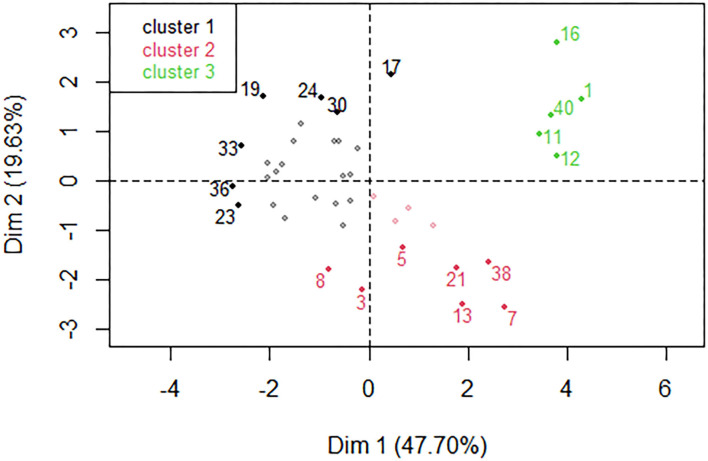
Hierarchical classification of the individual samples by HCPC revealed three clusters color-coded black (cluster 1), red (cluster 2) and green (cluster 3). A few individuals with the strongest influence in each cluster are shown for illustrative purposes.